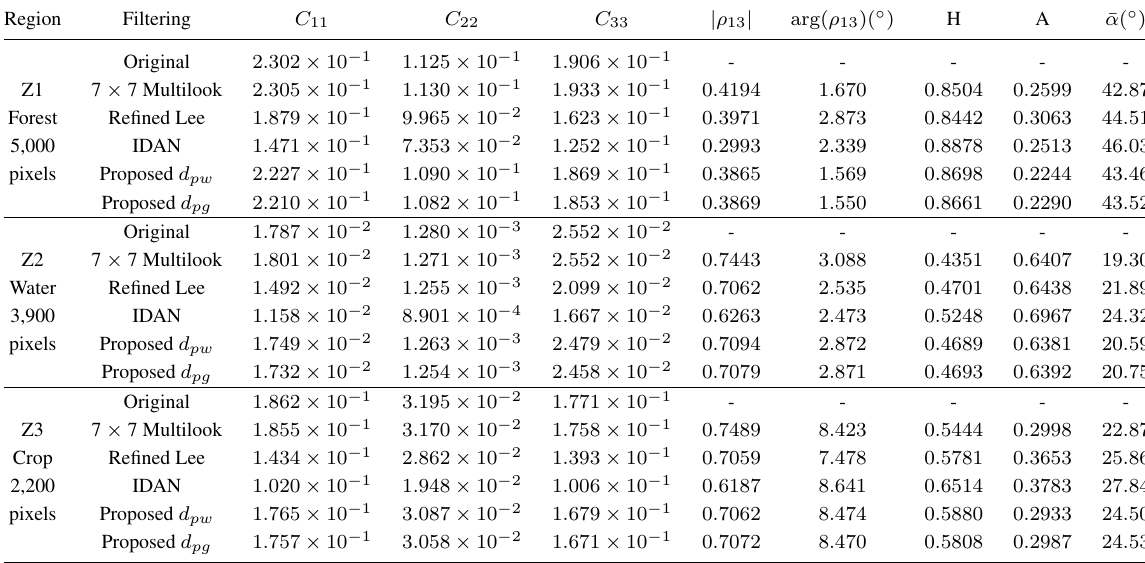
Table 1. Mean estimated values over homogeneous areas for different filtering techniques.